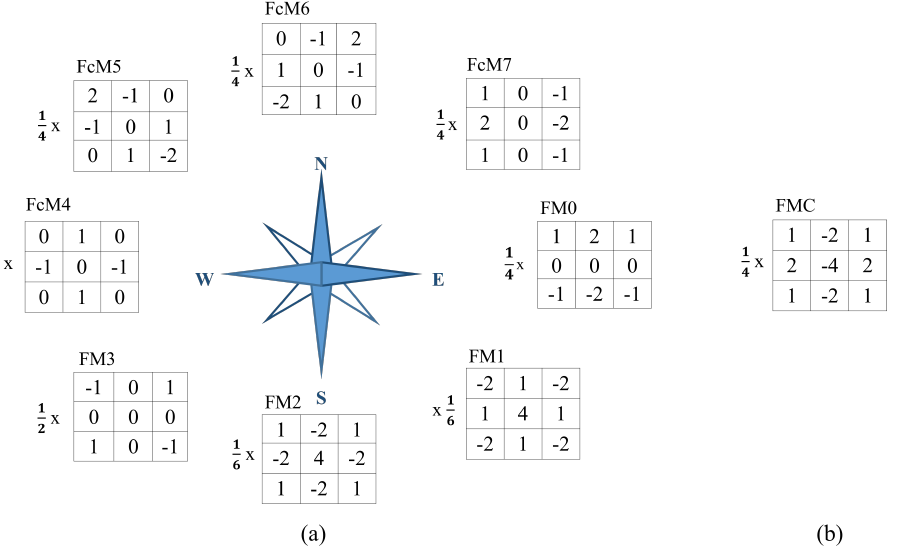
Figure 3. Block diagram of proposed color local directional ternary pattern (CLDTP).